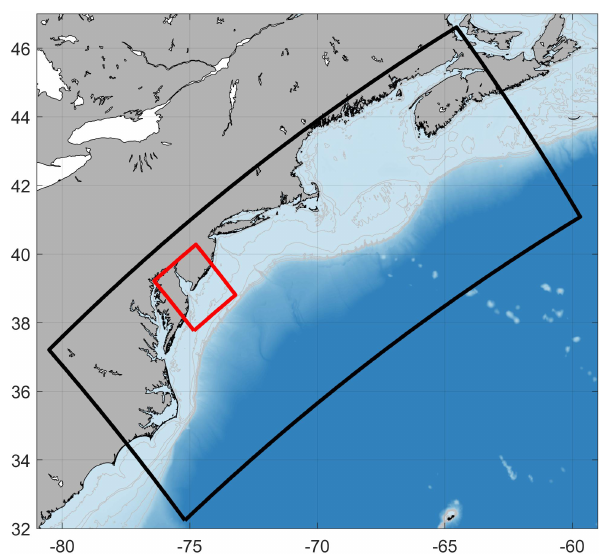
Figure 1. Map of the test domains. Black outlines the Doppio grid with ∼ 7km resolution. Red outlines the SnailDel domain with ∼ 1km resolution.